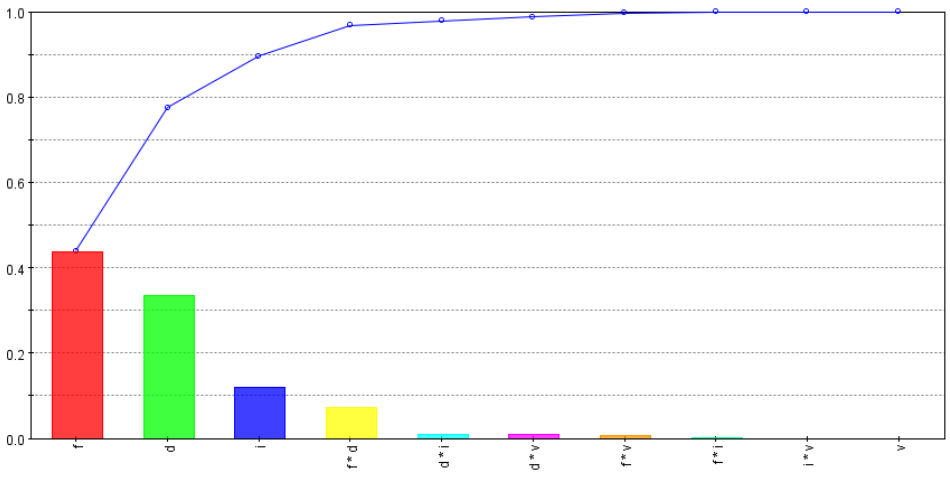
Figure 9. Specific-cutting-energy dependencies on input variables and their interactions.